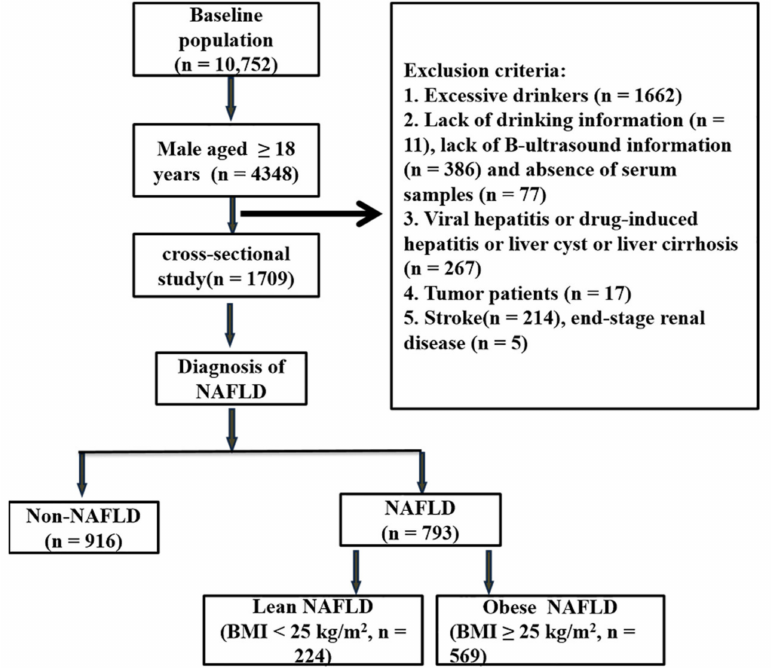
Figure 1. The flow diagram of study design. NAFLD, Nonalcoholic fatty liver disease; lean NAFLD, non-alcoholic fatty liver disease patients with body mass index <25 kg/m 2 ; Obese NAFLD; non- alcoholic fatty liver disease patients with body mass index ≥ 25 kg/m 2